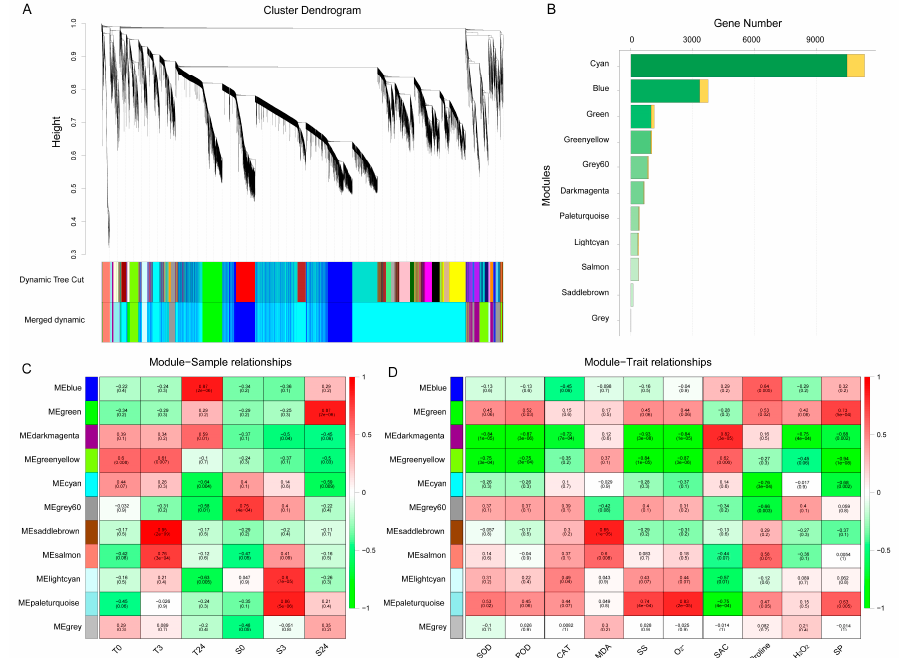
Figure 5. Weighted gene coexpression network analysis (WGCNA) of 19,982 DEGs obtained from all pairwise comparisons. ( A ) Hierarchical clustering tree showing 11 coexpression modules identified by WGCNA. Different modules are marked with different colors. Each leaf of the cluster tree represents a gene. ( B ) The number of transcription factors and nontranscription factor genes for each module. The orange bar indicates transcription factors, and the green bar indicates nontranscription factor genes. ( C ) Module–sample correlations and corresponding p -values. Each row represents a specific module, and each column represents a sample. The heatmap on the right shows the Pearson correlation between module eigengenes and samples. The numbers in each cell represent the correlation coefficients and correlation significance levels (in parentheses). The color of the cell reflects the degree of correlation. ( D ) Module–trait correlations and corresponding p -values. These traits correspond to the eight physiological indexes mentioned